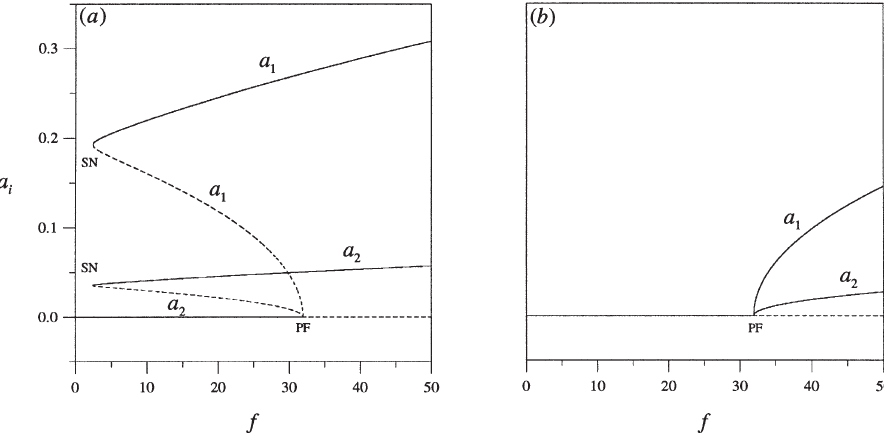
Fig. 3. Amplitude-response curves for a combination parametric resonance of the additive type involving modes 1 and 2 when (cid:22) 1 = 0 : 0137 and (cid:22) 2 = 0 : 0635. In part (a), (cid:27) = (cid:0) 1 and in part (b), (cid:27) = 1. Solid lines (—) denote stable fixed points and dashed lines (– – –) denote unstable fixed points.